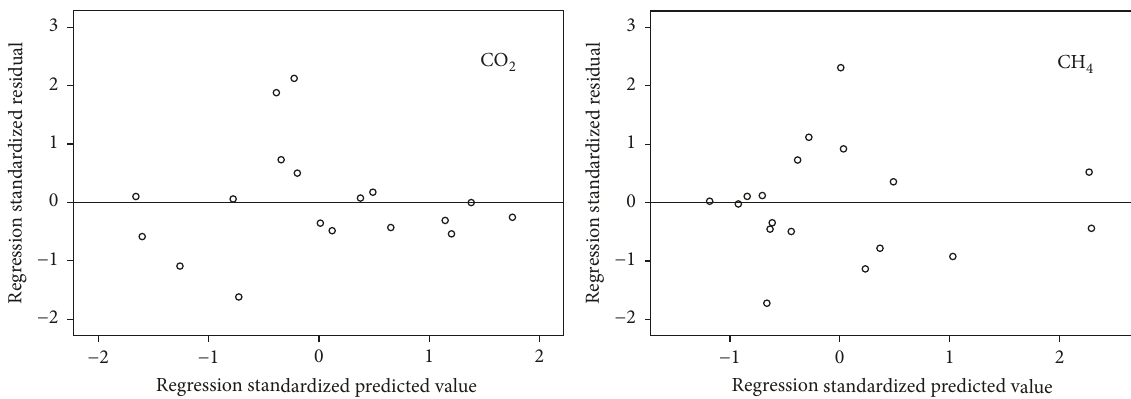
Figure 7: The scatterplot of regression standardized residual versus predicted value of lg CO 2 and lg CH 4 .